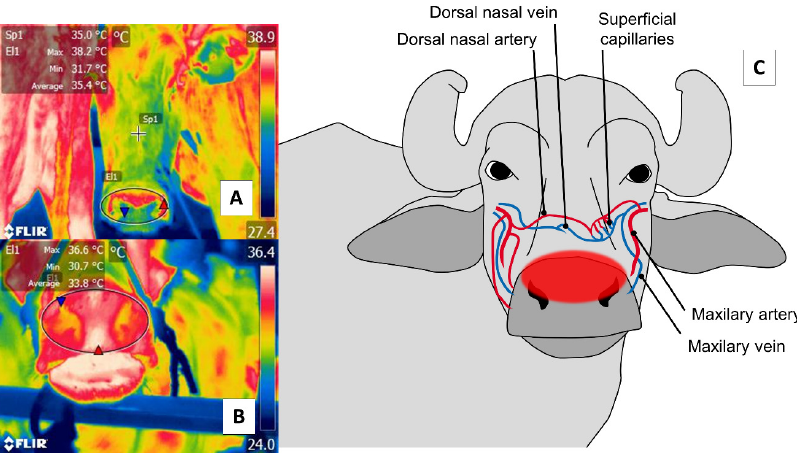
Figure 5. Nasal thermal window. ( A ) Cattle; ( B ) river buffalo. A circle is drawn (El1) around the muzzle of the nasal region ( regio nasalis ) to include both nostrils and the middle groove. This region permits evaluations of two conditions: first, changes in the microcirculation of the surface capillaries of the maxillary artery, as shown in ( C ); second, the elimination of water vapor during the respiratory process that makes it possible to assess, from a distance, the respiratory rate by observing changes in the thermal pattern at the central level of the nostrils.